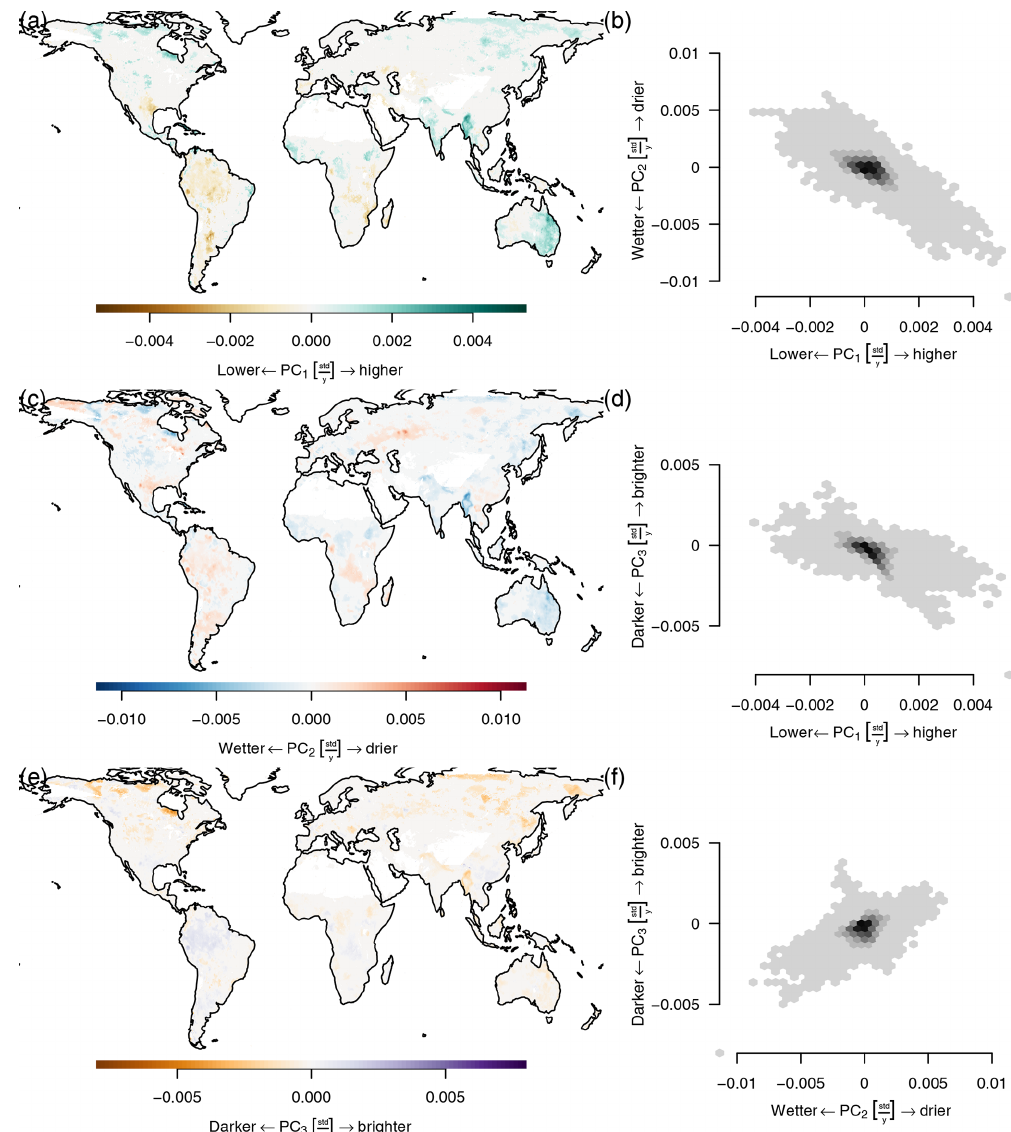
Figure 10. (a, c, e) Trends in PC 1 –PC 3 , respectively (2001–2011). (b, d, f) Bivariate distribution of trends. Trends were calculated using the Theil–Sen estimator. Panels (a) , (c) , and (e) show significant trends only ( p < 0 . 05, Benjamini–Hochberg